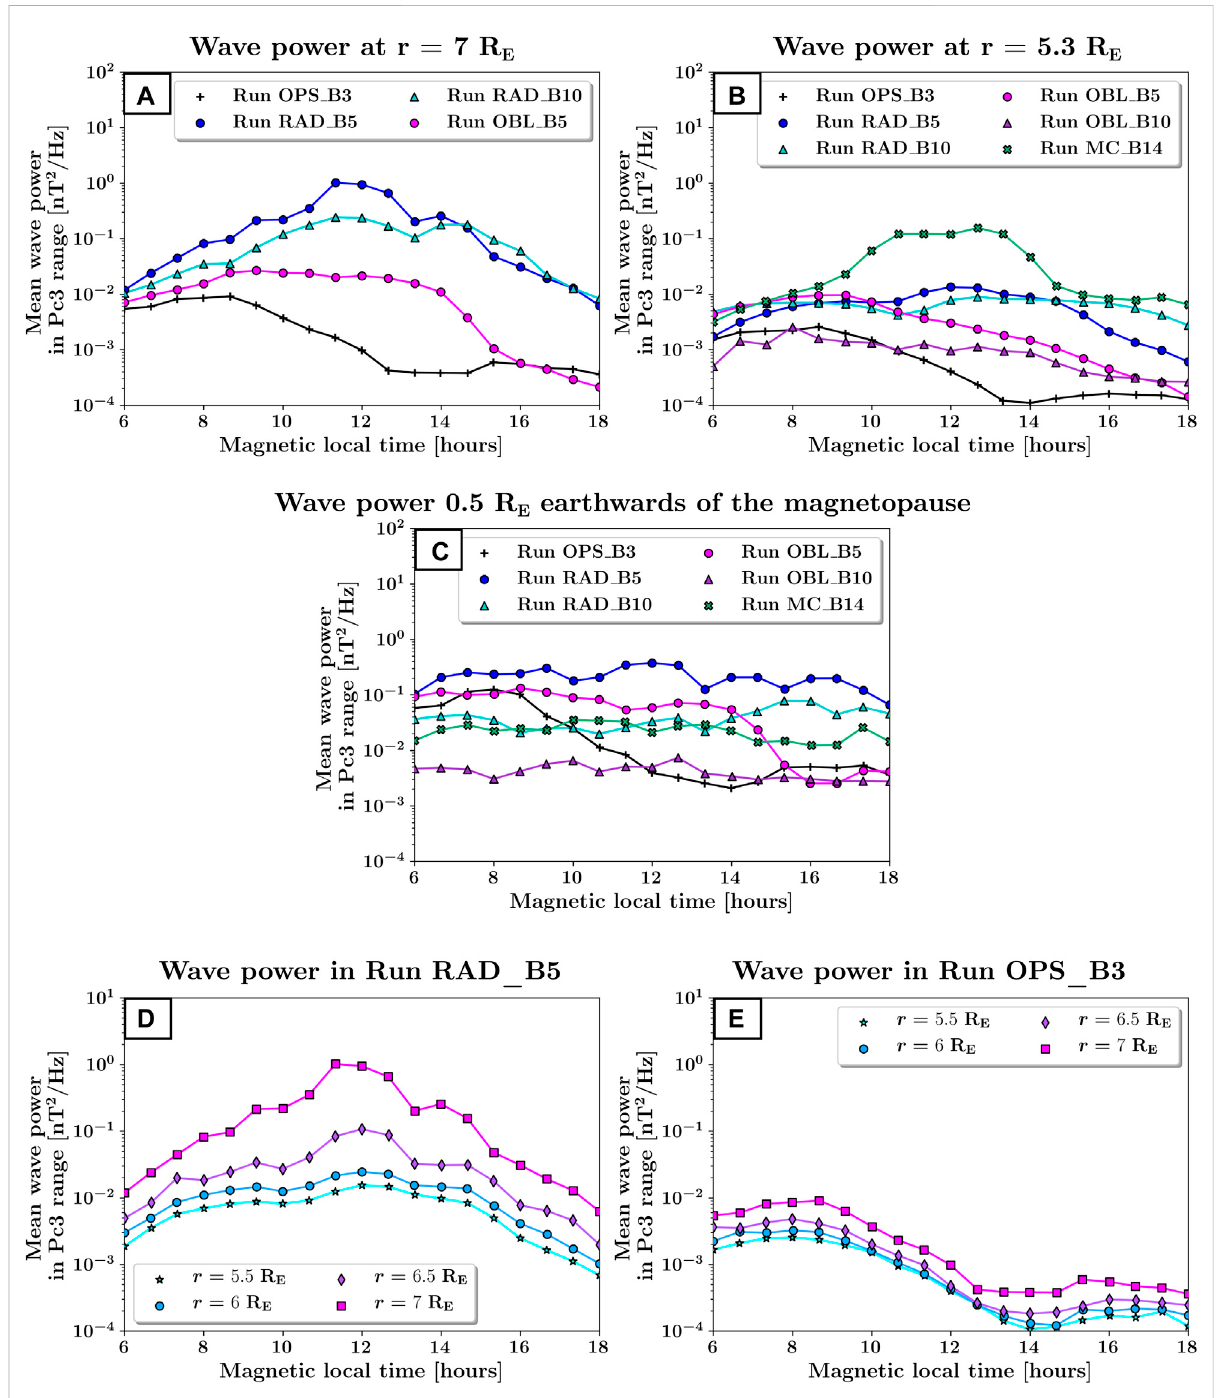
FIGURE 6 Top panels: Compressional wave power in the dayside magnetosphere at r = 7 R E and r = 5.3 R E . Middle panel: Compressional wave power 0.5 R E earthwards of the magnetopause, determined as an isocontour at β * = 0.28. Bottom panels: Compressional wave power in the dayside magnetosphere at different radial distances in Runs RAD_B5 (left) and OPS_B3 (right). Note that the dawn and dusk sectors have been reversed for Run OPS_B3 to facilitate comparison with the other runs, so that the foreshock is located in the dawn fl ank in all runs with non-radial IMF